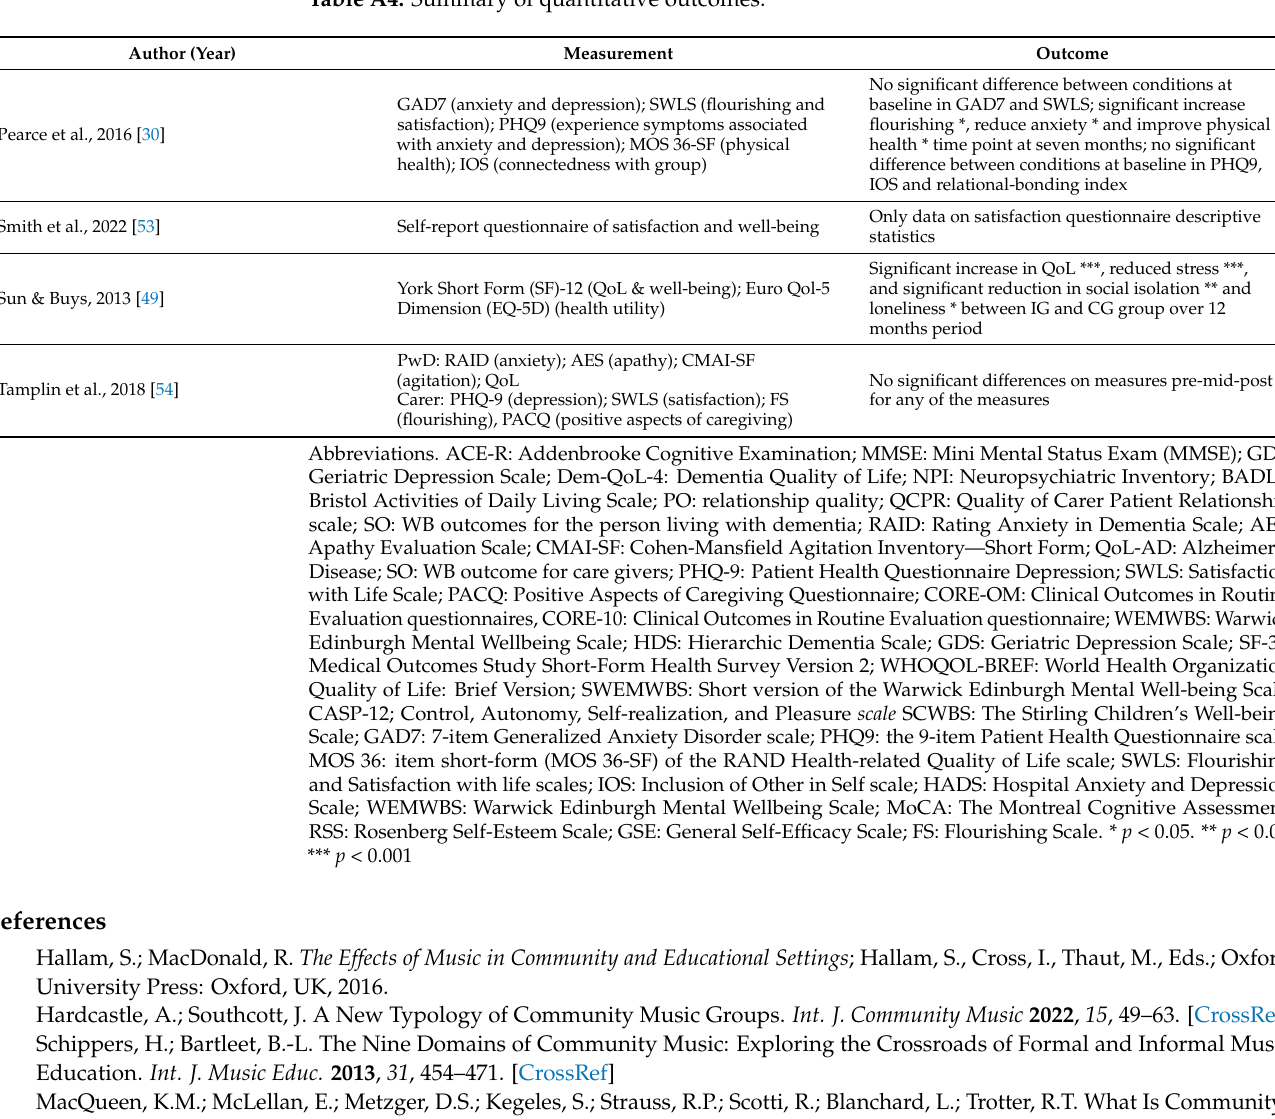
Table A4. Summary of quantitative